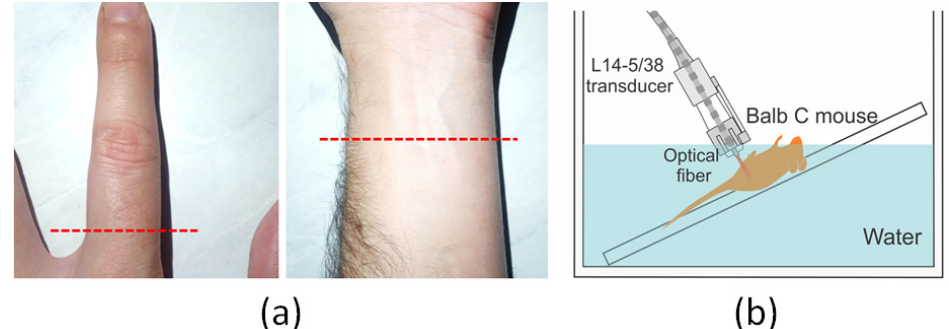
Figure 4. ( a ) Photographs of the index finger and forearm of the volunteer. The dashed lines indicate the position and orientation of the transducer. ( b ) Depiction of the experimental setup used to acquire in vivo PA images of Balb/C mouse.